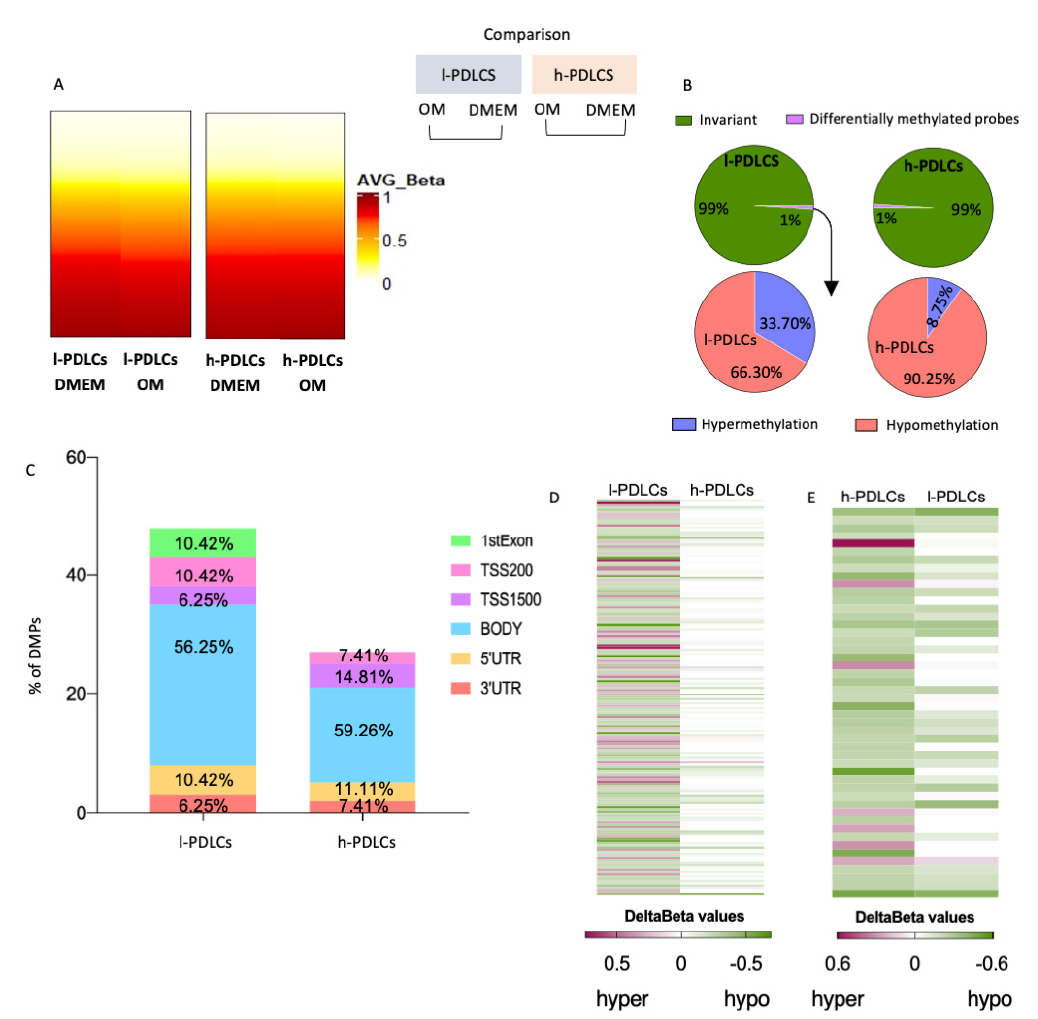
Figure 5. DNA methylation changes upon osteogenic stimulation in PDLCs with distinct osteogenic potential. ( A ) DNA methylation probe data (Infinium Methylation EPIC BeadChip assay) were compared between l- and h- PDLCs cultured for 10 days in OM vs. DMEM (unstimulated controls). Hydroxymethylation data are shown in Supplementary Figure S3. ( B ) Proportion of differentially methylated probes (DMPs) in l- and h-PDLCs (upper graphs) and distribution of hypo- and hyper-methylated events (lower graphs). ( C ) Genomic localisation of DMPs in l- and h- PDLCs. ( D , E ) Heatmaps comparing hyper- or hypomethylated probes in l-PDLCs ( D ) and h- PDLCs ( E ), as determined by delta beta values. Probes differentially methylated in l-PDLCs were identified in h-PDLCs ( D ), and the same was performed for h-PDLCs. ( E ) l-PDLCs/DMEM, perio- dontal ligament cells with low osteogenic potential at basal levels; h-PDLCs/DMEM, periodontal ligament cells with high osteogenic potential at basal levels; l-PDLCs/OM, periodontal ligament cells with low osteogenic potential at day 10 day of osteogenic stimulation in vitro ; h-PDLCs/OM, periodontal ligament cells with high osteogenic potential at day 10 day of osteogenic stimulation in vitro. 3.5. Progression in Osteoblast Phenotype Following Osteogenic Induction Is Limited by Persistent DNA Hypermethylation in l-PDLCs The most relevant differences between h-PDLCs and l-PDLCs were observed when DNA methylation and chromatin accessibility were compared between the two OM data